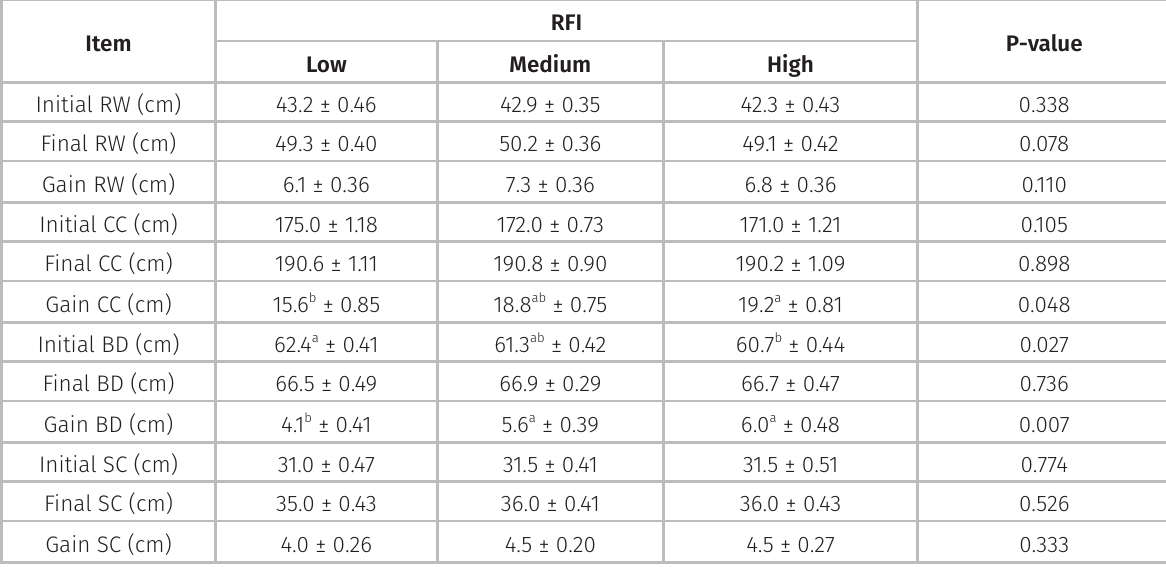
Table IV. Body morphometric measurements of Nellore bulls classified according to their residual feed intake